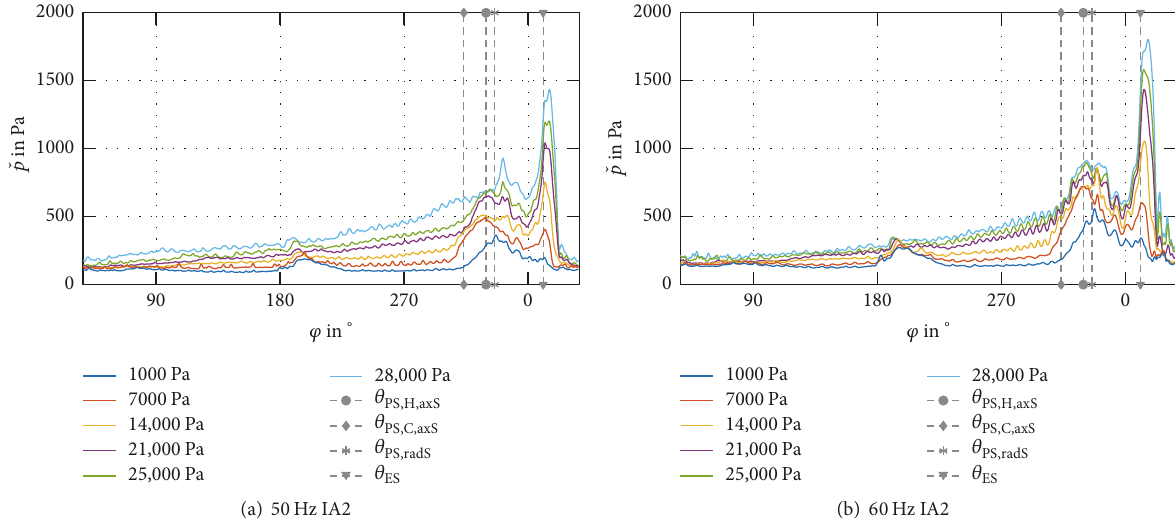
Figure 13: Standard deviation of pressure ̌𝑝 on the blade surface for impeller arrangement 2 (IA2).